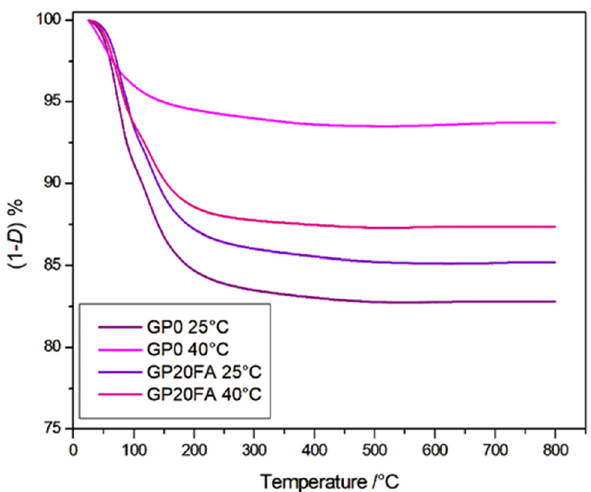
Figure 8: DSC curves, from room temperature up to 500°C, for GP0 at 25°C, GP0 at 40°C, GP20FA at 25°C, and GP20FA at